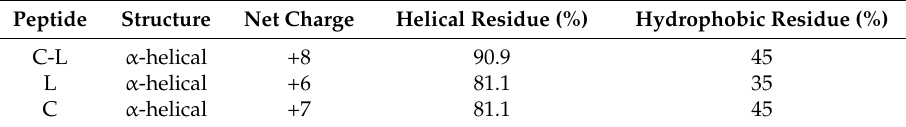
Table 2. Structure parameters of the peptides predicted by online software Jpred 4 and